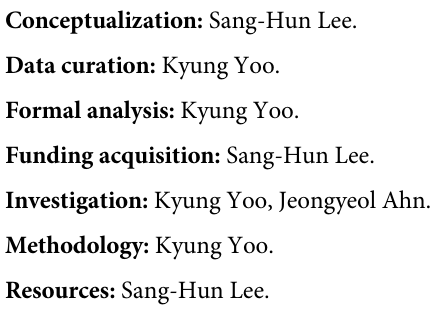
S1 Fig. Individual’s BPR shape remains constant across runs. (left panel) Split-half correla- tion in peak amplitudes (right panel) Split-half correlation in peak time. S2 Fig. Zoomed out diagonal plot for Fig 9B and 9C. S1 Video. Example of blink-locked pupillary response